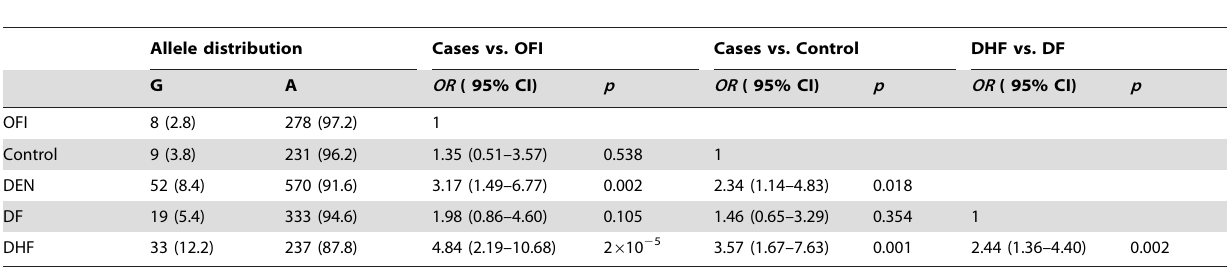
Table 3. Distribution of CD209 2 336 A/G (rs4804803) allele in patients with dengue infection (DEN) and other non-dengue febrile illnesses (OFI) or population controls.